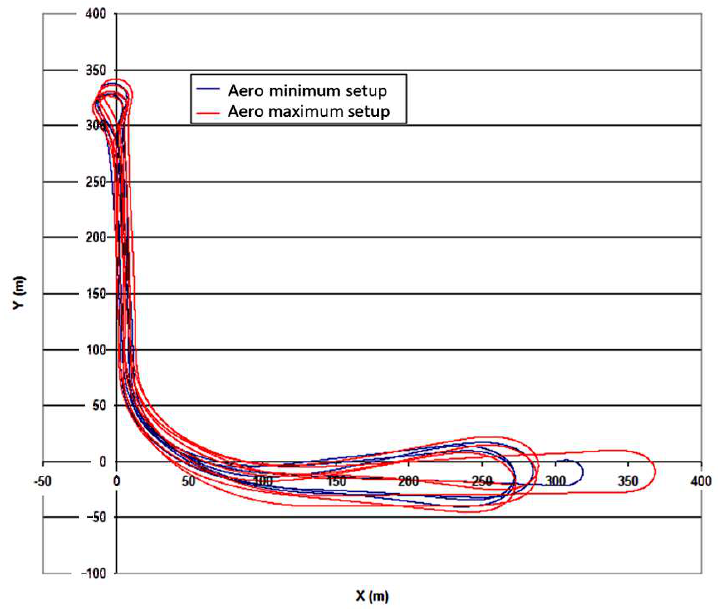
Figure 33. Trajectories of the test vehicle with minimum and maximum aerodynamic setups.